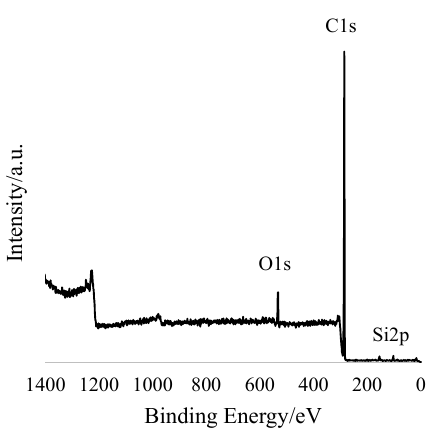
Figure 3. XPS survey spectrum of the 203.75 g/m 2 sample. Table 1. Composition of 203.75 g/m 2 and 295.5 g/m 2 mats based on XPS survey spectra.